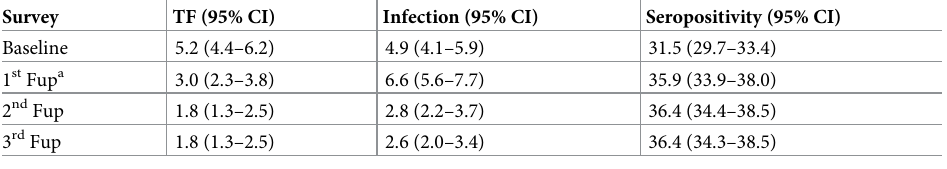
Table 2. Cross-sectional TF, infection, and seropositivity percentages of subjects who participated in each survey as shown in Fig 1.